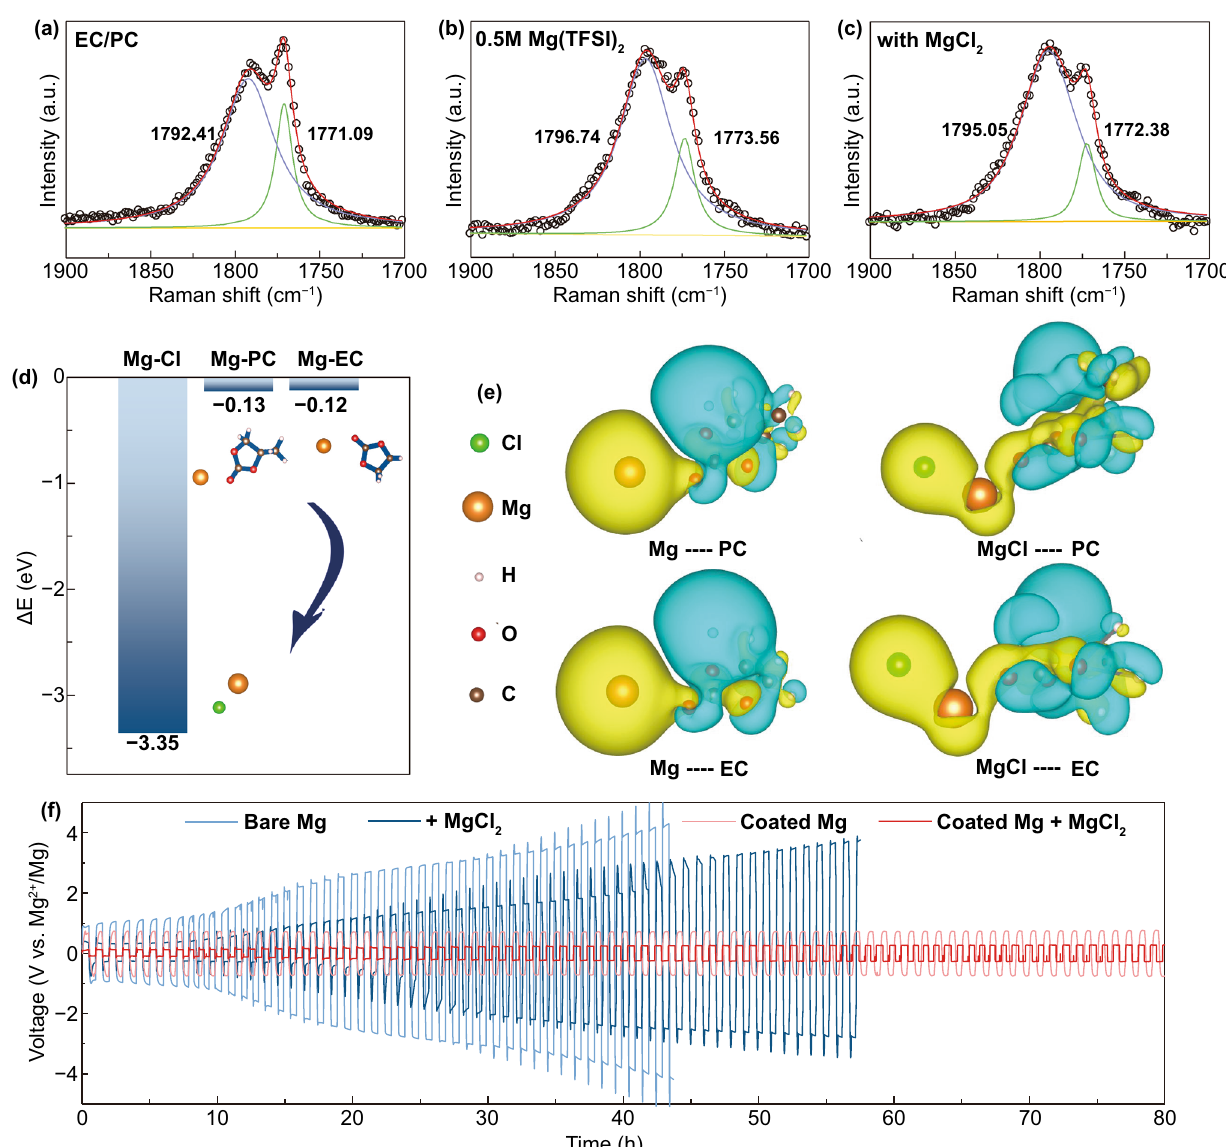
Fig. 3 FT-Raman spectra of the following solution: a EC/PC (1:1, volume ratio), b 0.5 M Mg(TFSI) 2 in EC/PC (1:1, volume ratio), c MgCl 2 / Mg(TFSI) 2 electrolyte. d The calculated interaction energy of Mg-Cl, Mg-PC and Mg-EC. e Differential charge density plots for the group of Mg and solvent molecules with or without Cl. The yellow color shows the aggregation of electron cloud while blue color indicating the loss of electron cloud. f Voltage responses of symmetric Mg batteries with and without Mg 2+ -conductive interphase and MgCl 2